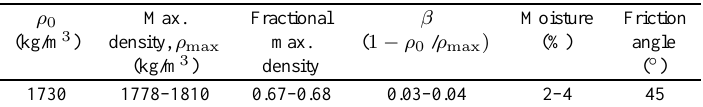
Table 2 Calculated final and fractional densities of the compacted soil and depths of